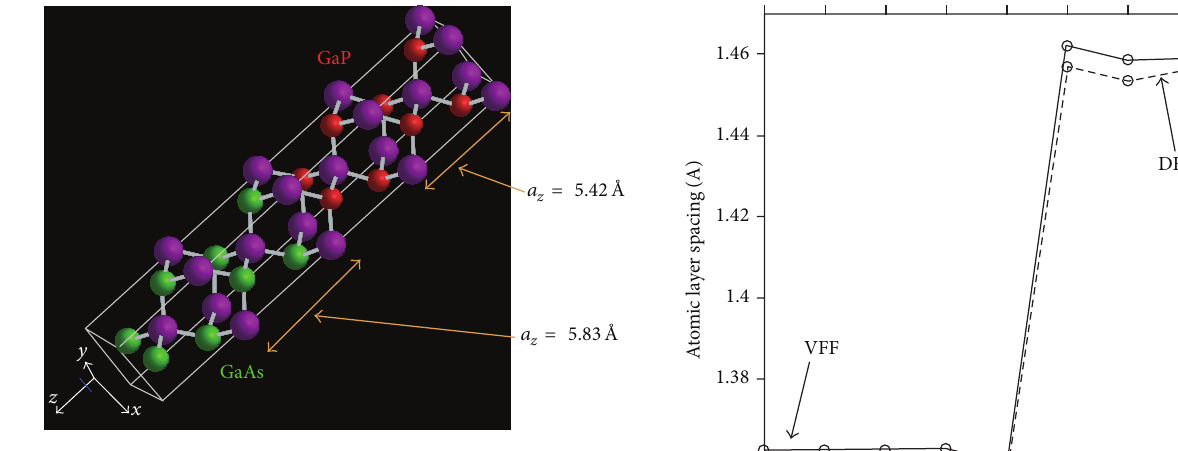
Figure 6: Schematic representation of a short-period GaAs(4)/ GaP(4) [001] superlattice grown on a GaP substrate after the atomic relaxation. The lattice parameters along the [100] and [010] directions are both equal to that of GaP.